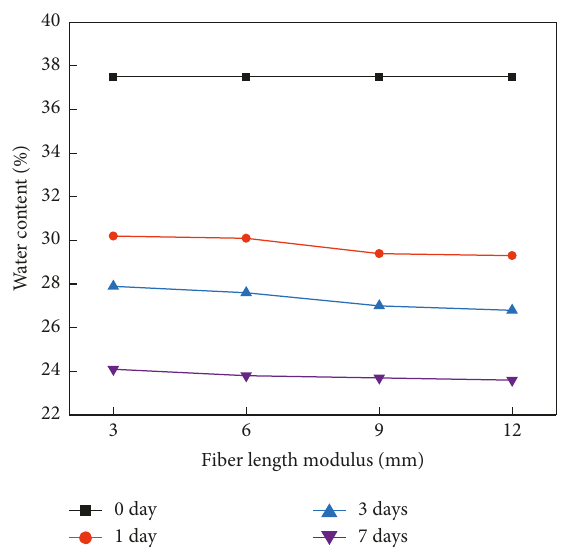
Figure 7: Diagram of variation of the water content of remolded soil with fiber length modulus at different conservation ages.